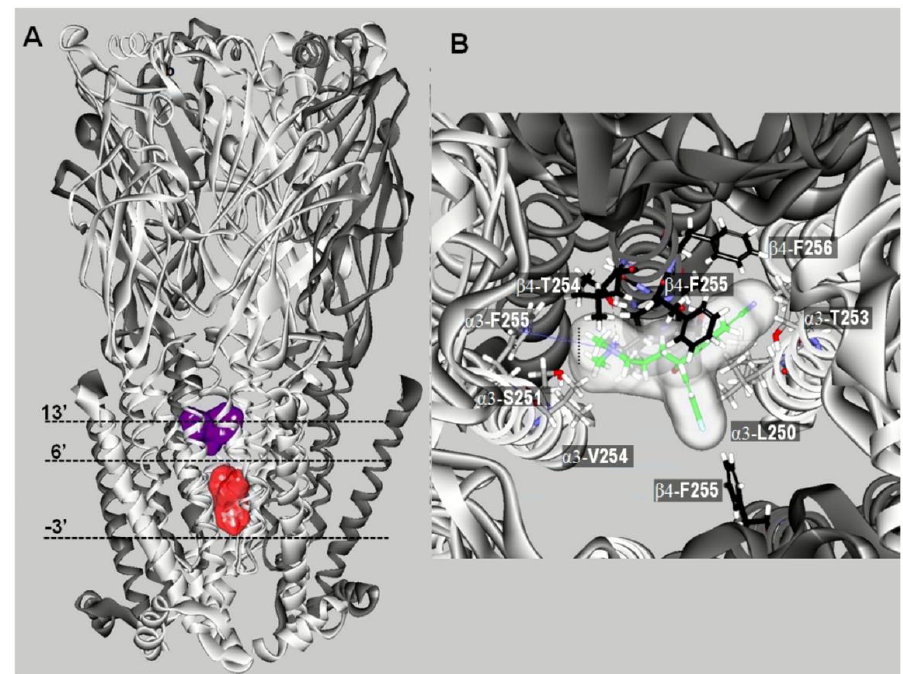
Figure 4. Docking sites for S-(+)-citalopram (escitalopram) in the (α3) 3 (β4) 2 nAChR model (modified from [68]). ( A ) Escitalopram docked at two luminal sites (surface model): a high-affinity site located closer to the extracellular ion channel’s mouth (blue) and a low-affinity site located closer to the cytoplasmic side (red). The α3 (white) and β4 (dark gray) subunits are represented as solid ribbons. Dotted lines indicate the positions of the Gly (position -3′), Ser (position 6′), and Val (position 13′) rings along the ion channel. ( B ) Detailed view of escitalopram at the high-affinity luminal site, showing the cation–π interaction with α3-F255 (position 14′) and the interaction with β4-T254 (position 12′).